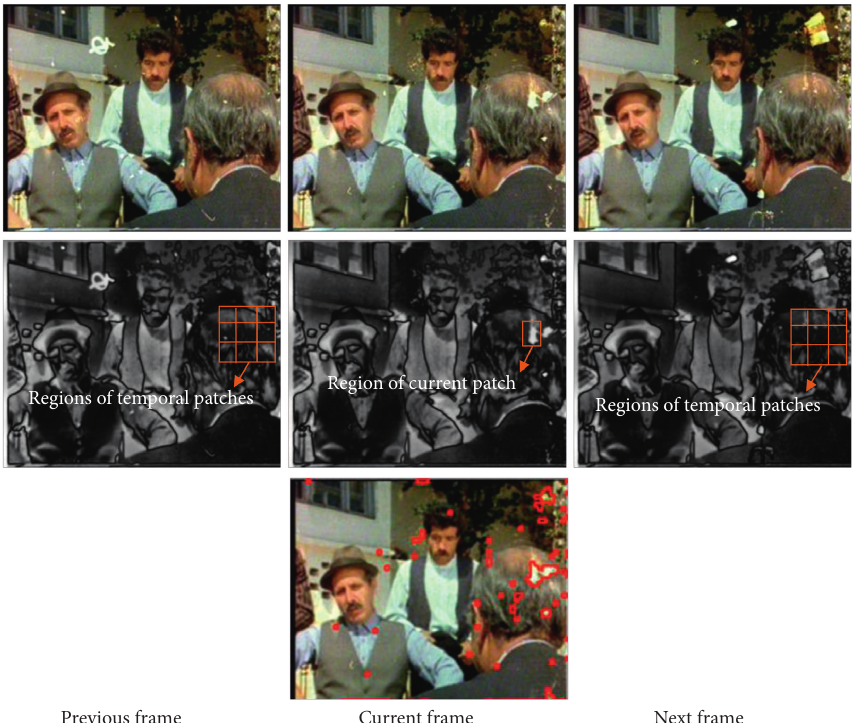
Figure 5: Proposed blotch detection method based on the visual saliency map: consecutive frames (top row), comparing the total number of saliency pixels in the spatiotemporal patches (middle row), and detected blotches marked red in colour in the current frame (bottom